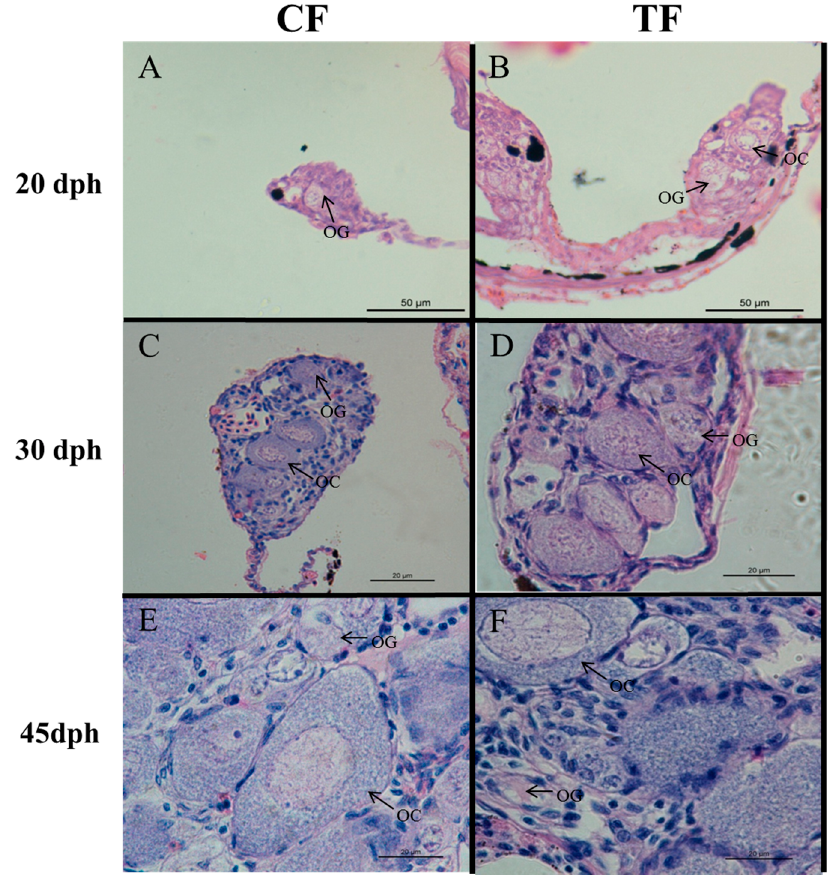
Figure 1. Gonad histology of control females (CF) and high-temperature-treated females (TF) at various developmental stages. ( A , C , E ) gonad of 20, 30 and 45 dph control female, respectively; ( B , D , F ): gonad of 20, 30 and 45 dph high-temperature-induced males, respectively OG: oogonia; OC: oocyte; dph: days post-hatching.